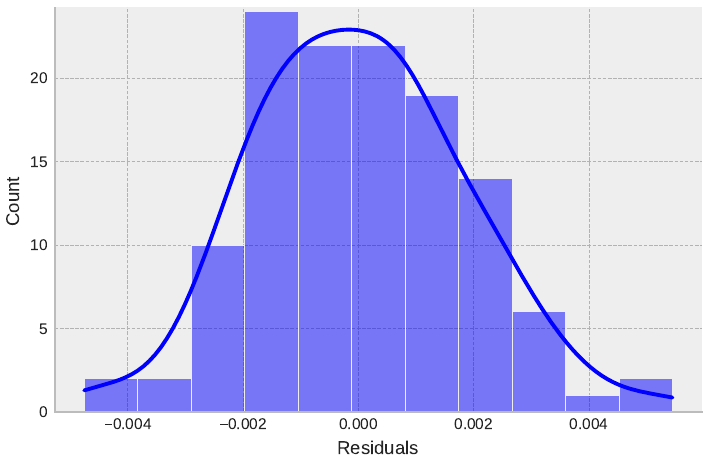
Figure 10. Distribution of the